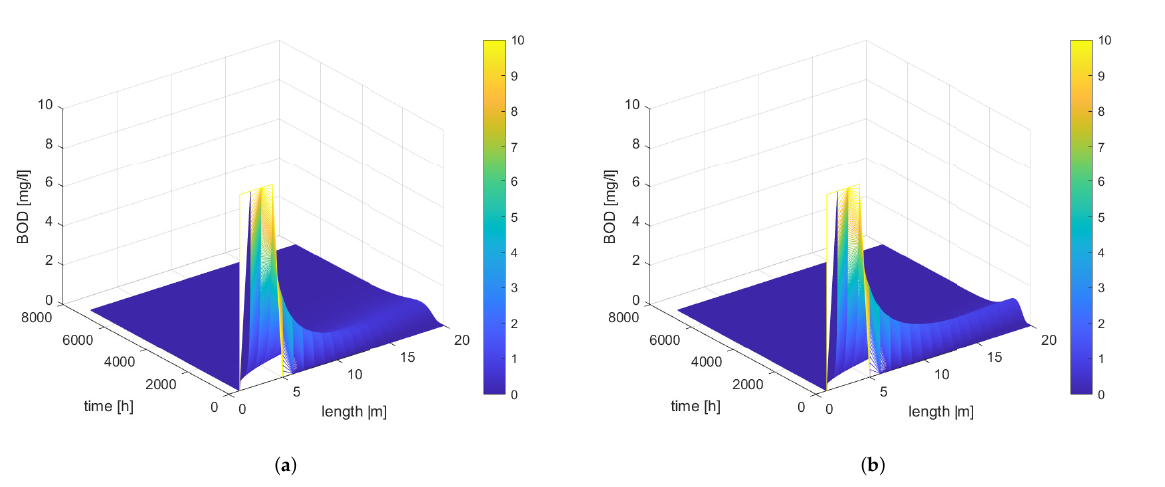
Figure 5. BOD distribution for V = 0.005 ( a ) V = 0.01 ( b ) including the self-cleaning